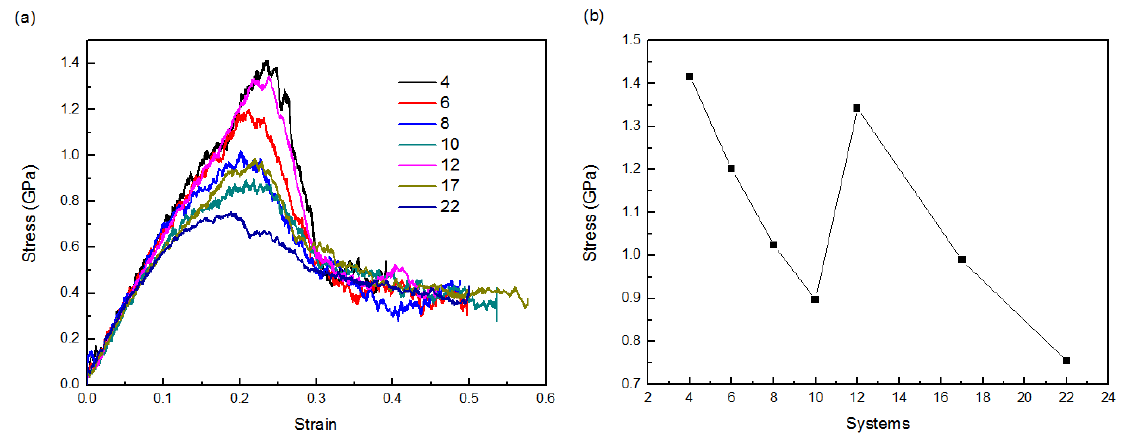
Figure 5 : Strain–stress curves (a) in Z axis during compressing, and the maximum stress of different systems (b) in Z axis during